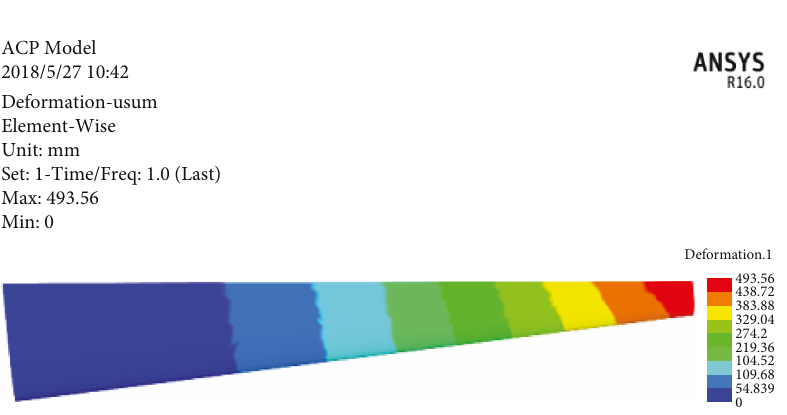
Figure 29: Deformation cloud diagram with the layer angle being 45 and 0.